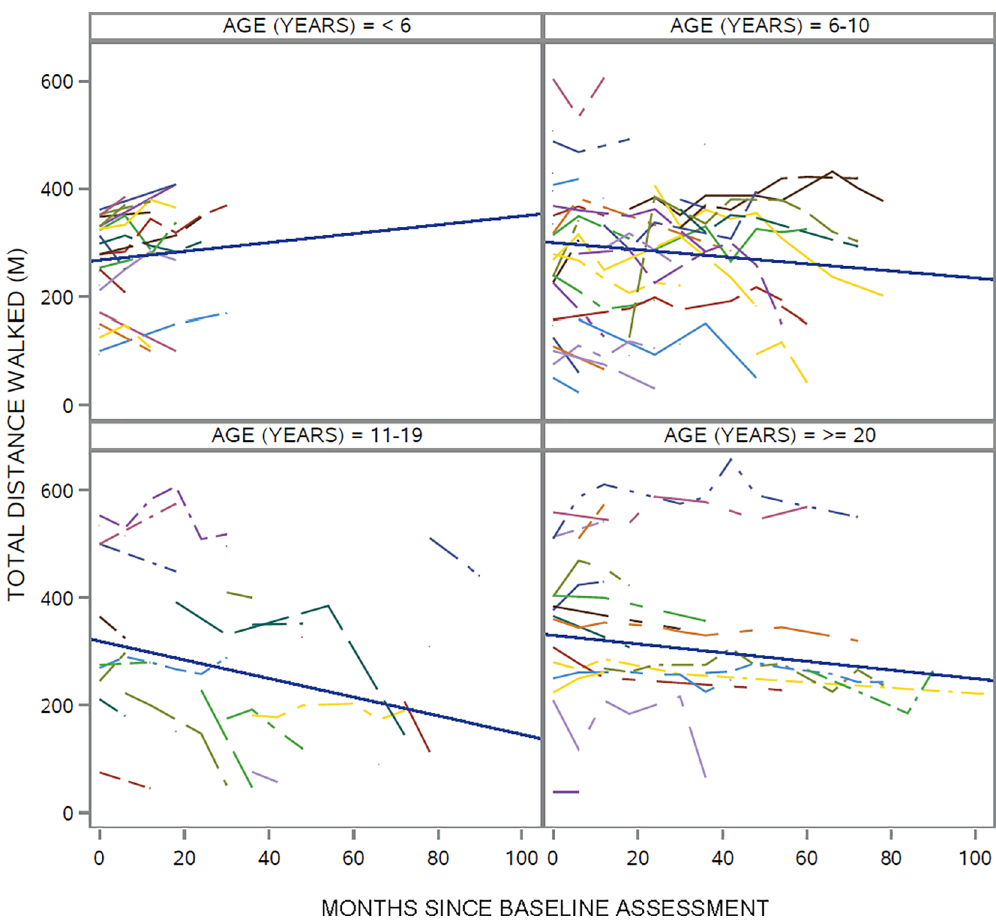
Fig 2. Individual trajectories and average trajectory of 6MWT distance by age